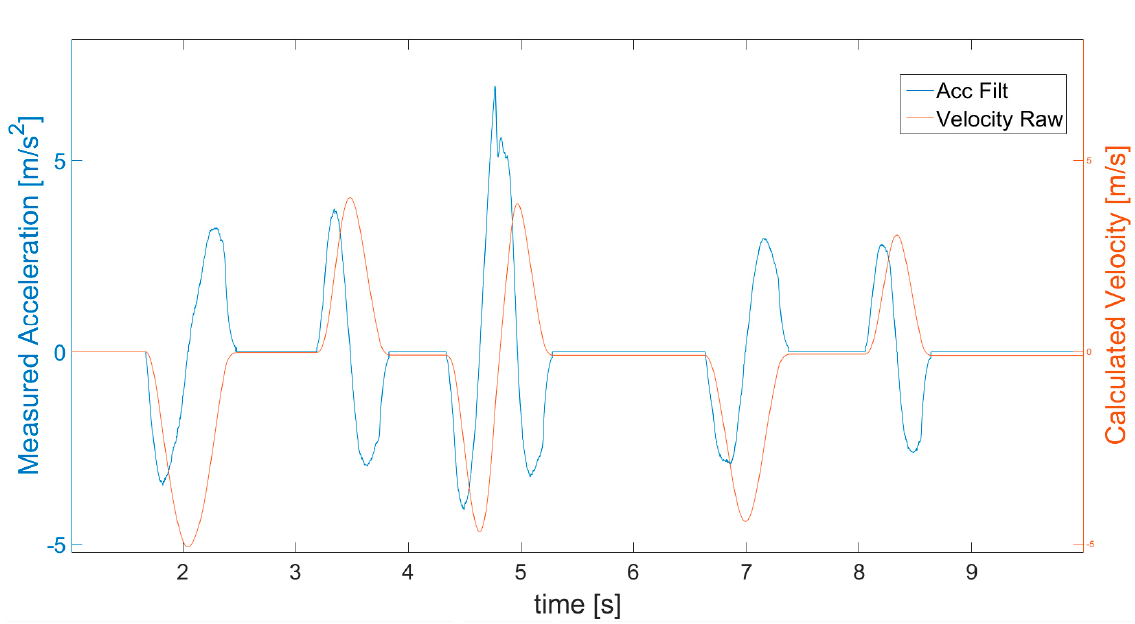
Figure 6. Velocity (red line) calculated with simple derivative of filtered acceleration (blue line).